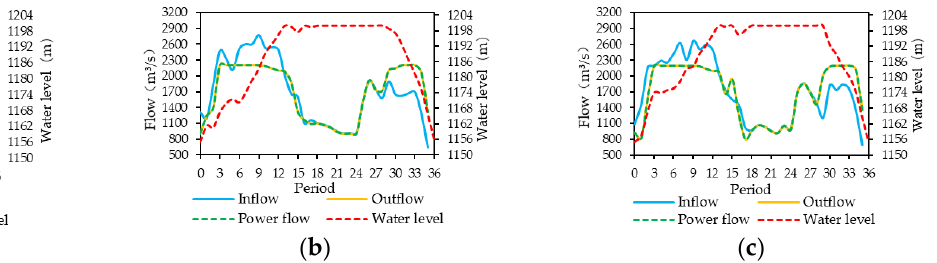
Figure 9. Operation hydrographs of the Guandi Reservoir using ( a ) Scheme 1, ( b ) Scheme 2 and ( c ) Scheme 3.